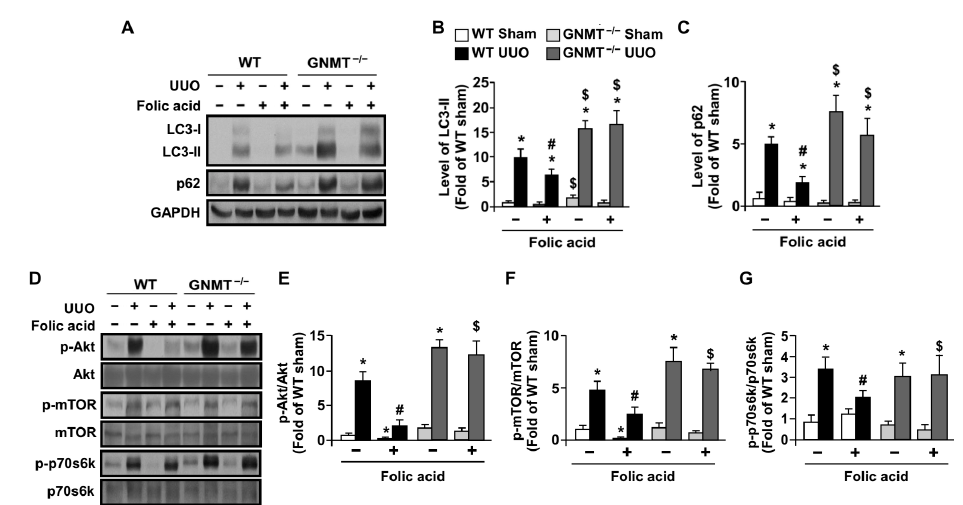
Figure 7. Effect of folic acid on UUO-induced autophagy and its regulatory pathway in WT and GNMT − / − mice. ( A – C ) Tissues extracted from kidneys were analyzed via immunoblotting with antibodies against the autophagy markers LC-3 and p62; GAPDH was used as a loading control. ( D – G ) Tissues extracted from kidneys were analyzed via immunoblotting with antibodies against autophagy-related signaling pathway components: these included phosphorylated Akt, mTOR, and p70s6k, as well as total Akt, mTOR, and p70s6k. * p < 0.05 versus the sham group of WT mice, # p < 0.05 versus non-folic acid-treated UUO WT mice, $ p < 0.05 versus folic acid-treated UUO WT mice.